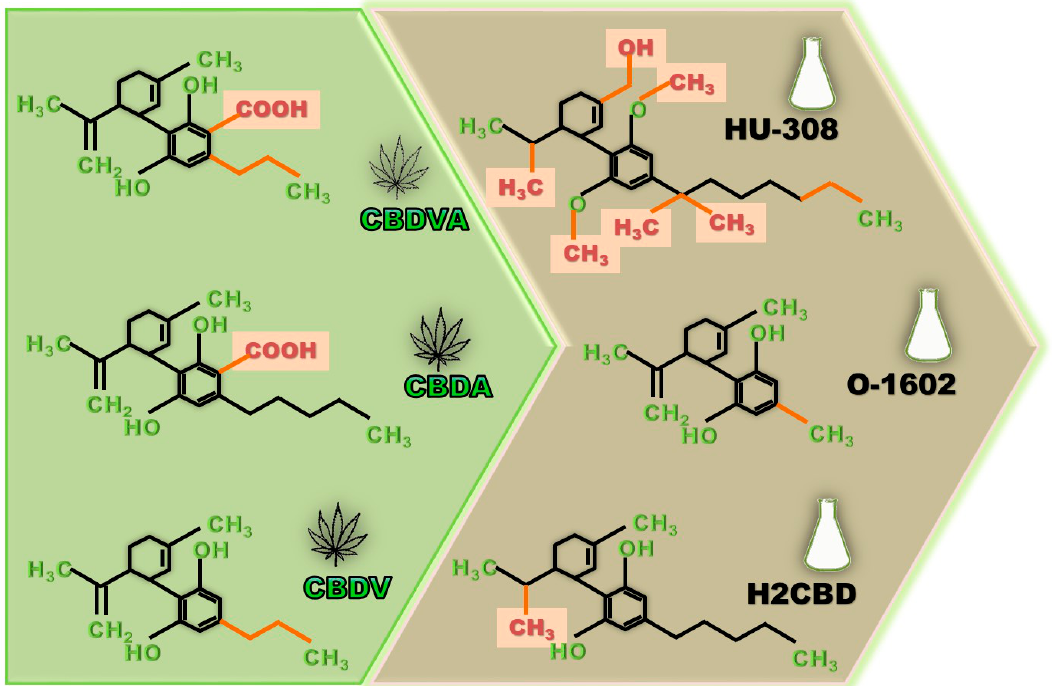
Figure 2. Examples of the chemical structures of some natural cannabinoids (green box) and of synthetic CBD derivatives (brown box) that recently have attracted attention in the search for an- ti-seizure medications. CBDVA, cannabidivarinic acid; CBDA, cannabidiolic acid; CBDV, canna- bidivarin; HU-308, pinene dimethoxy-DMH-CBD derivative; O-1602, a synthetic cannabinoid; H2CBD, 8,9-dihydrocannabidiol.